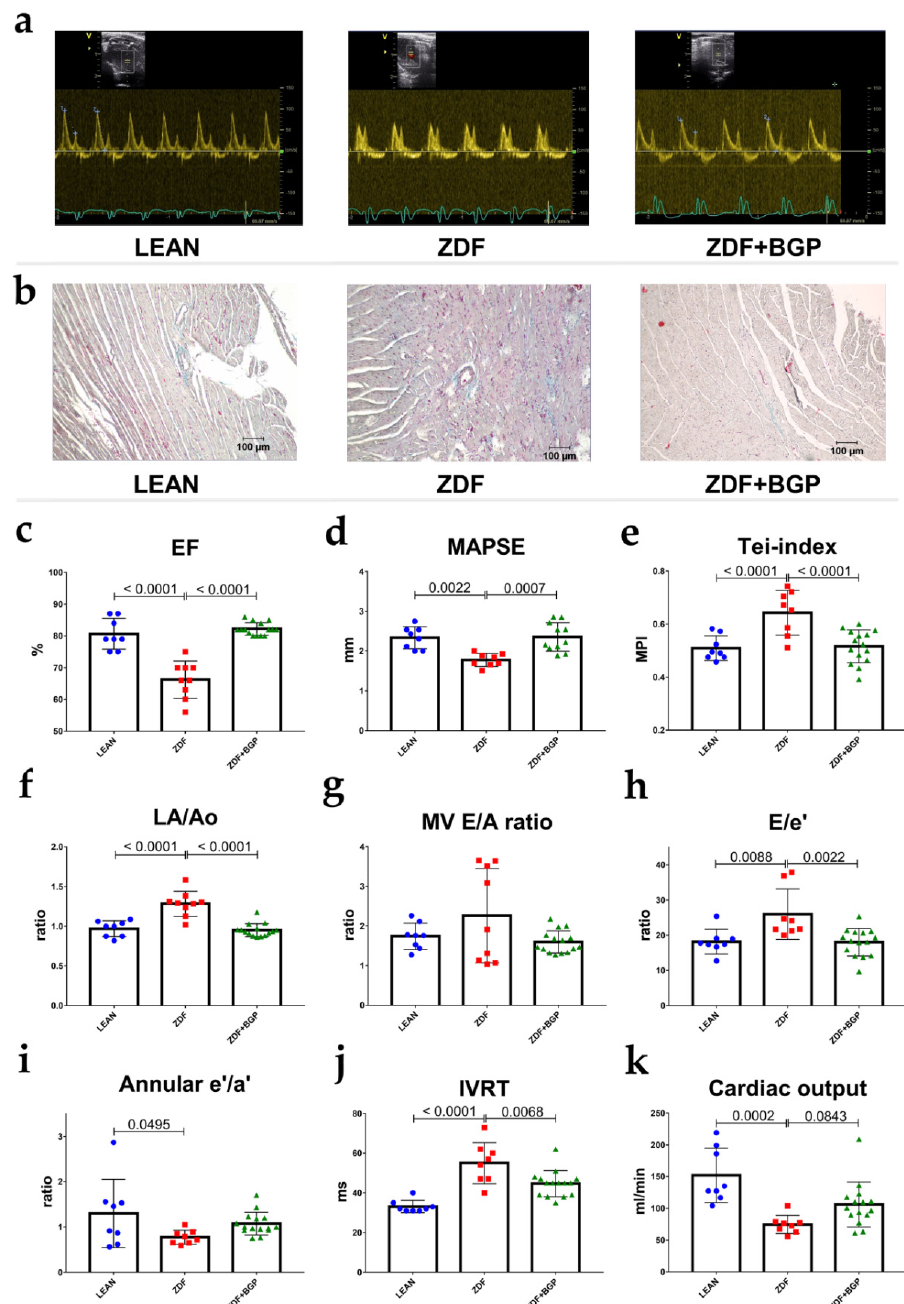
Figure 1. Echocardiographic parameters of rats at the endpoint of the study. BGP-15 treatment improved the echocardiographic parameters of aged ZDF rats. ( a ) Representative Doppler traces of the mitral inflow (E and A waves) in LEAN, ZDF, and ZDF+BGP groups, respectively. ( b ) Histological samples of the dissected heart tissues stained with Masson’s trichrome in LEAN, ZDF, and ZDF+BGP groups, respectively. Fibrotic tissue dyes with blue colour. ( c ) Ejection fraction (EF) in the three endpoints groups. EF was deteriorated in the ZDF, but was normal in the ZDF+BGP group. ( d ) Mitral annular plain systolic excursion (MAPSE) improved in the treated animals. ( e ) Tei-index (Myocardial Performance Index, MPI) worsened in the ZDF but improved in the ZDF+BGP group. ( f ) Left atrial enlargement (LA/Ao) improved in the treated animals. ( g ) Mitral valve inflow E/A ratio (MV E/A) in the endpoint groups. ( h ) E/e’ ratio, indicating left ventricle filling pressure was elevated in the ZDF but was restored in the ZDF+BGP group. ( i ) Septal annular wall motion e’/a’ ratio worsened in the ZDF animals. ( j ) Isovolumic relaxation time (IVRT) lengthened in the ZDF,